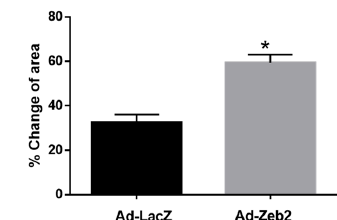
Figure 4. Zeb2 overexpression increases contraction of P1 myofibroblasts—a characteristic of mature myofibroblasts. ( A ) P1 cells were plated on collagen gels and transduced with either Ad-LacZ or Ad-HA-Zeb2 and incubated for 72 h. After 72 h, collagen gels were cut and allowed to contract for 14 h. Images were taken at the 0 h and 14 h timepoints (4× objective). ( B ) The gel size was quantified using Measuregel software. Histographic representation shows the percentage of change of area in case of Zeb2 infected gels compared to Ad-LacZ control. n = 3, * p ≤ 0.05 vs Ad-LacZ. Error bars represent SEM. Data were analyzed by performing a Student’s t -test.